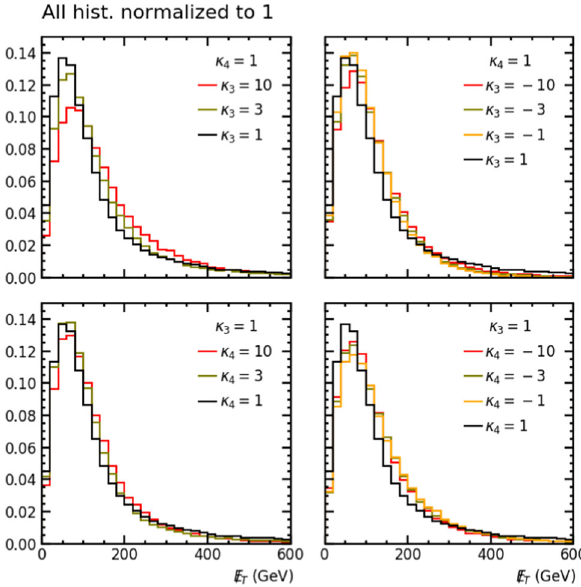
Fig. 31 Distribution of e + e − → b ¯ bb ¯ bb ¯ b ν ¯ ν events with respect to the transverse missing energy, for several values of the parameters κ 3 and κ 4